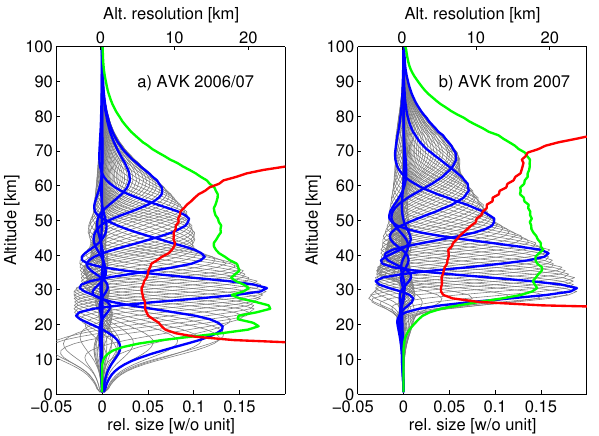
Fig. 5. Averaging kernels for the periods 2006/2007 (left panel) and 2008 onwards (right panel). Thick blue lines indicate averag- ing kernels (AVK) for the values at 30, 40, 50, 60, and 70km al- titude. Green solid lines denote sums of the AVKs, divided by 10. Solid red lines correspond to altitude resolution, given as FWHM of the Gaussian approximation to the AVKs, at the respective alti- tudes (axis at figure tops). The differences in the AVKs reflect the hardware changes as described in Sect. 2.2.